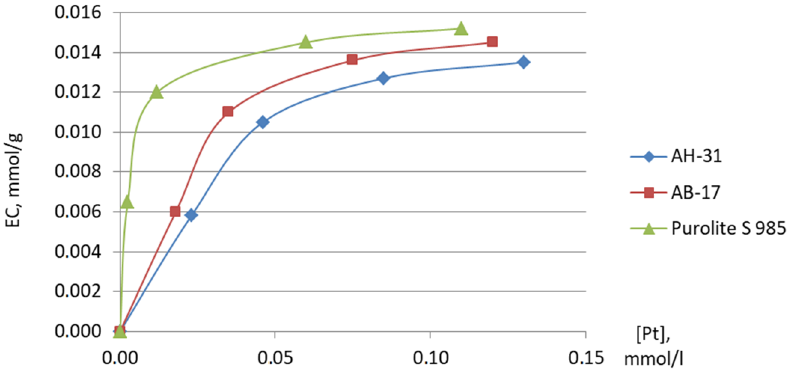
Figure 1. Isotherm of platinum sorption from sulfate-chloride solution: C Pt = 0.26 mmol/L; C H2SO4 = 0.5 mol/L; C HCl = 0.5 mol/L.